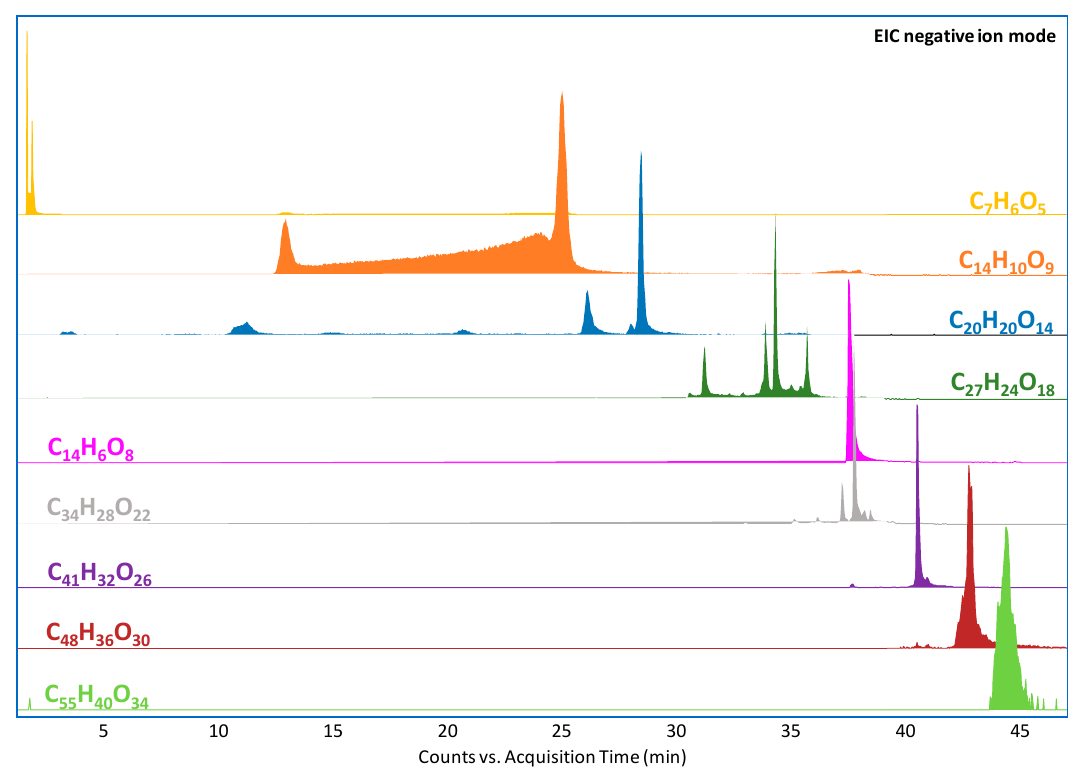
Figure 2. Extracted ion chromatograms from the extract of the nonaged yarn dyed with oak gallnuts without mordant. The molecular formulas correspond to gallic acid (C 7 H 6 O 5 , m/z 169.0142), galloyl-gallate (C 14 H 10 O 9 , m/z 321.0252), digalloyl-glucose (C 20 H 20 O 14 , m/z 483.0780), trigalloyl-glucose (C 27 H 24 O 18 , m/z 635.0890), ellagic acid (C 14 H 6 O 8 , m/z 300.9990), tetragalloyl-glucose (C 34 H 28 O 22 , m/z